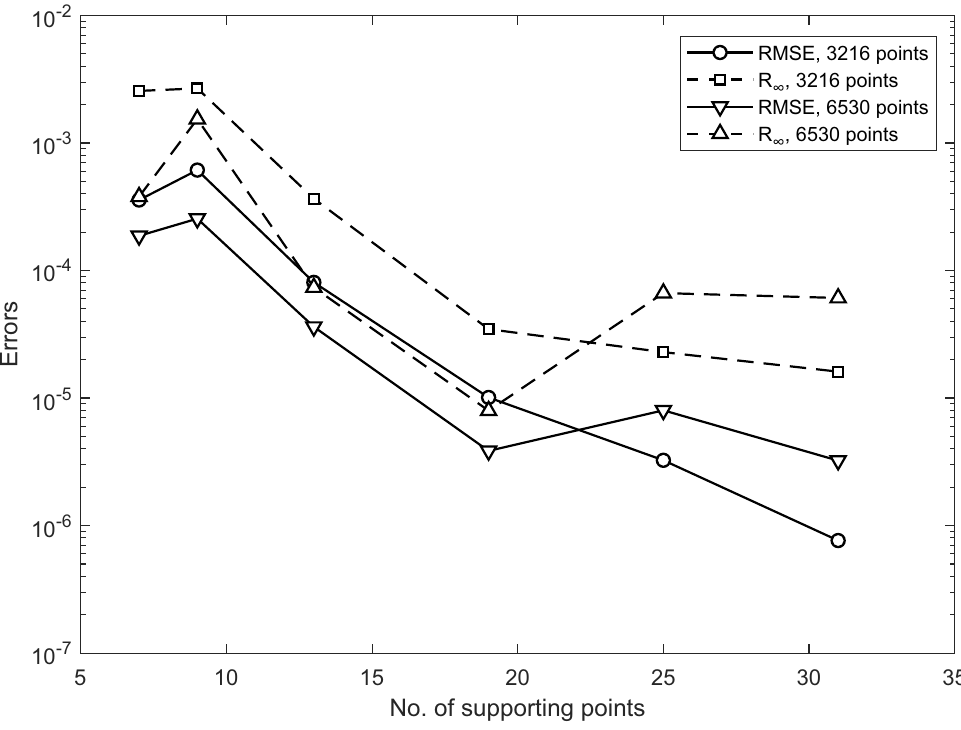
Figure 7. Example No. 2—course of RMSE and R ∞ for different numbers of supporting points.